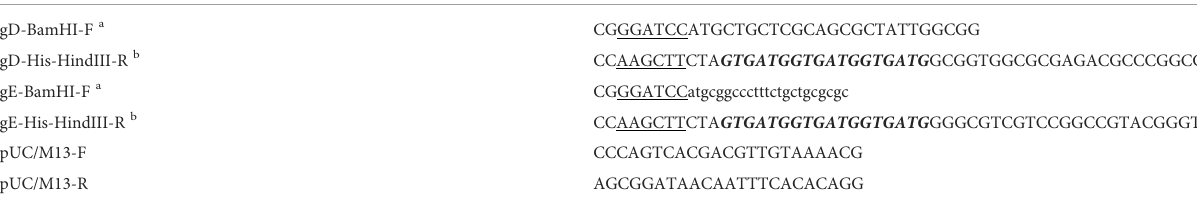
TABLE 1 Primers used in this